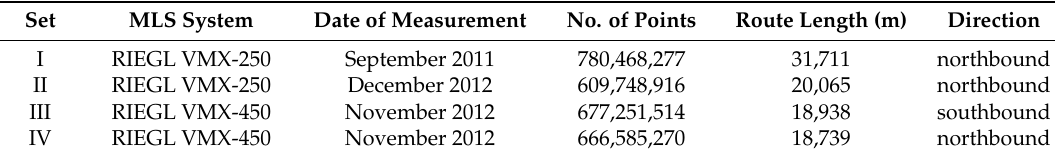
Table 1. Datasets used in the algorithm verification process.